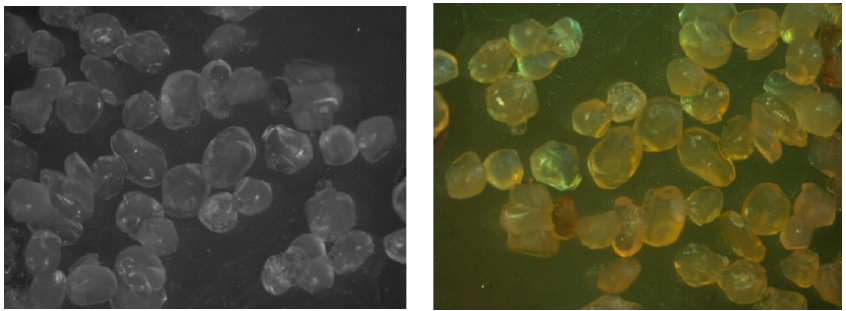
Figure 6. Microphotograph of the alginate microcapsules.